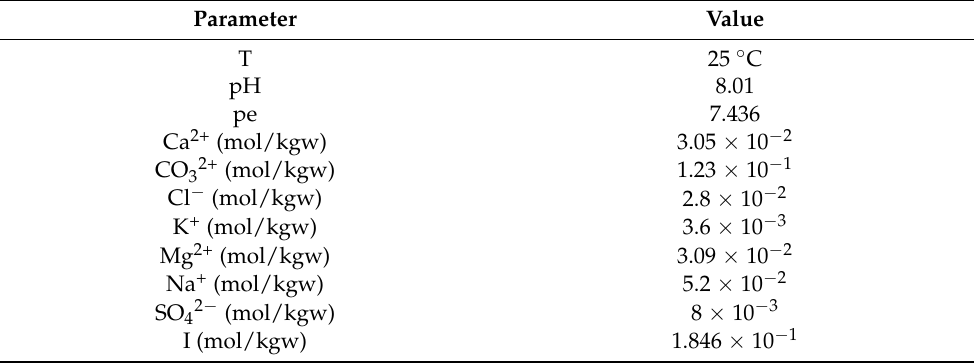
Table 8. Input parameters of the test case.